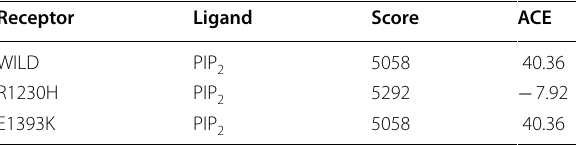
Table 14 Docking results of modeled PDB of PLCε1 with PIP using